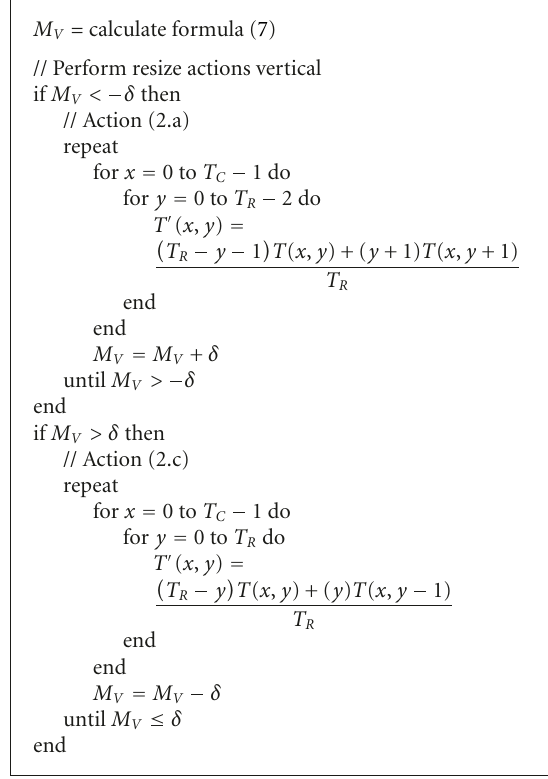
Algorithm 6: Perform resize actions